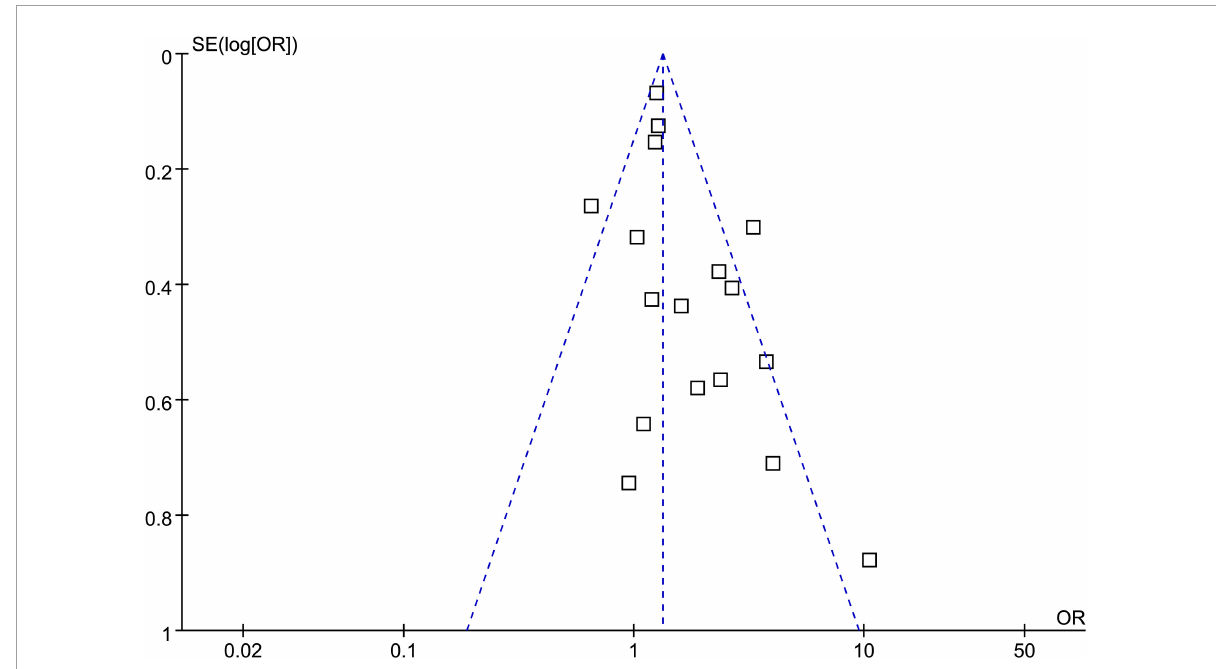
FIGURE3 Funnel plots assessing publication bias underlying the meta-analysis of psoriasis and overall coronary artery calcification